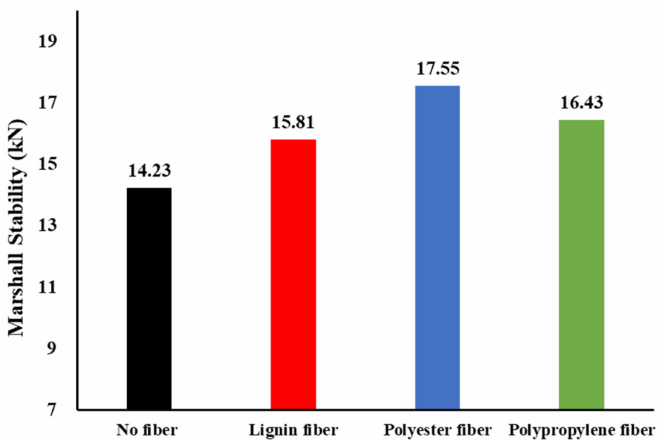
Figure 8. The results of Marshall